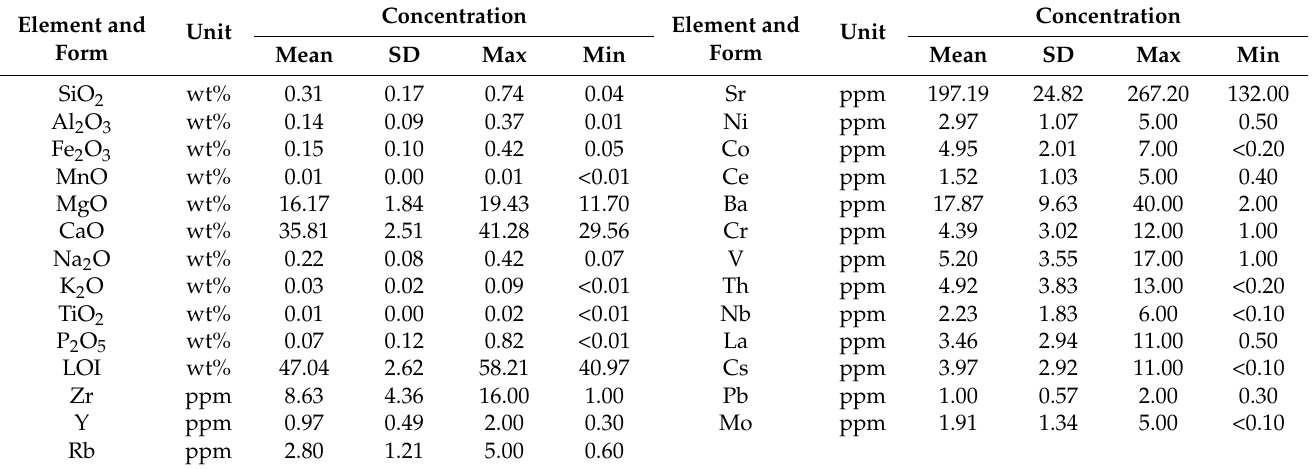
Table 4. Chemical composition of dolostones (n: 48). Statistical parameters. (SD: standard